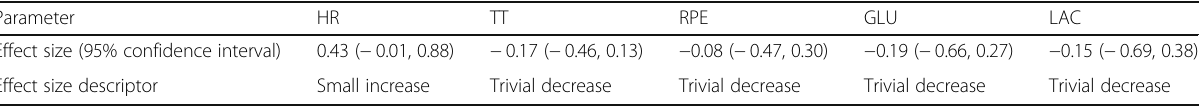
Table 2 Effect sizes and descriptors for parameters studied Parameter